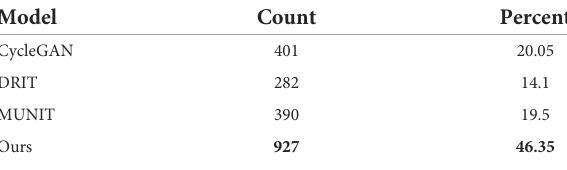
TABLE 1 User study preference for beautified